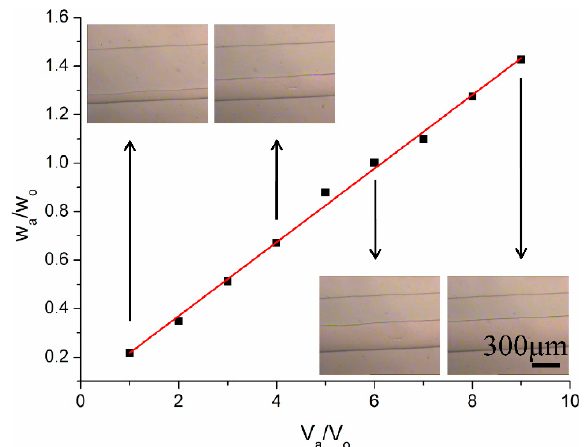
Figure 3. The standard curve of the relationship between the flow width ratio and the velocity ratio (inset: the microphotograph of stable laminar flow corresponding to individual velocity ratio, the top phase was the aqueous phase of pure water and the bottom phase was the organic phase of n-octyl alcohol).